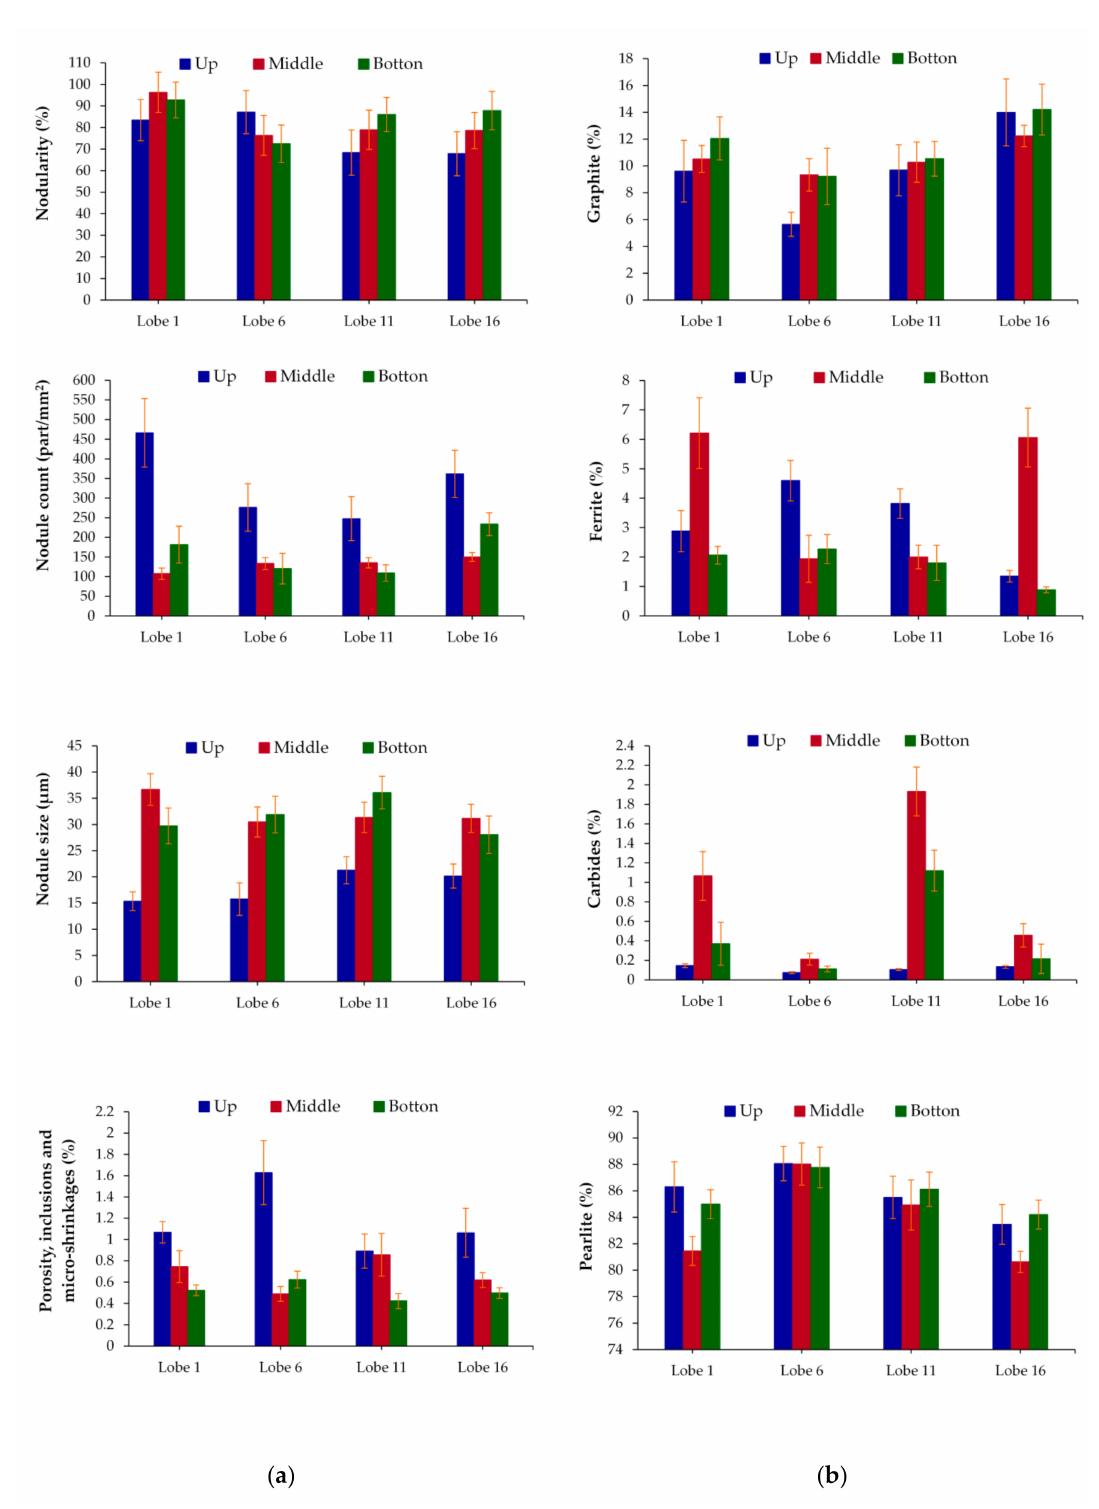
Figure 3. Microstructural characterization of the ductile iron alloyed with 0.2 wt % V for different lobes and regions analyzed to ( a ) graphite features ( b )